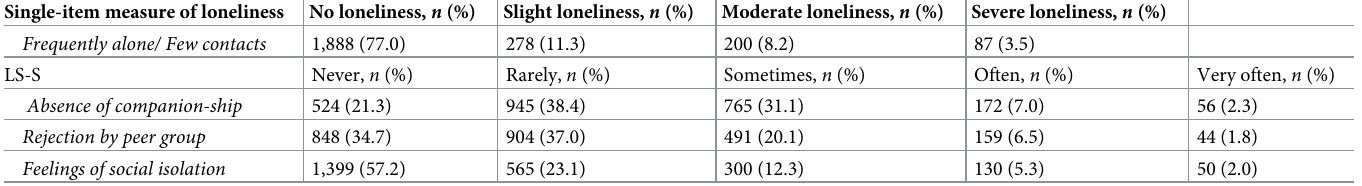
Note . LS-S = Loneliness